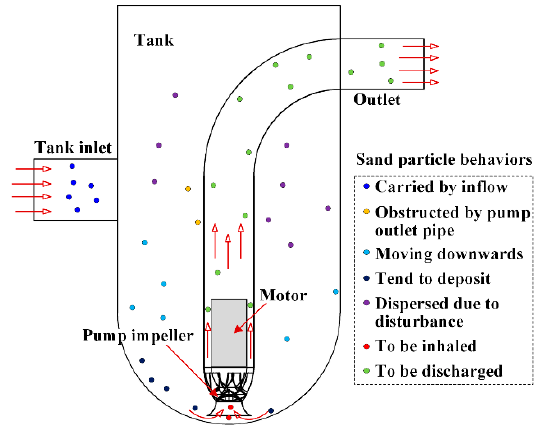
Figure 2. Various behaviors of sand particles in the prefabricated pumping station.